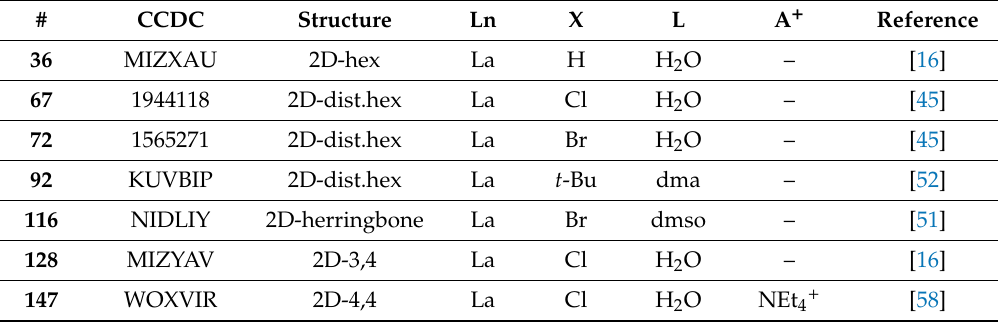
Table 14. Structurally characterized La(III) compounds with anilato